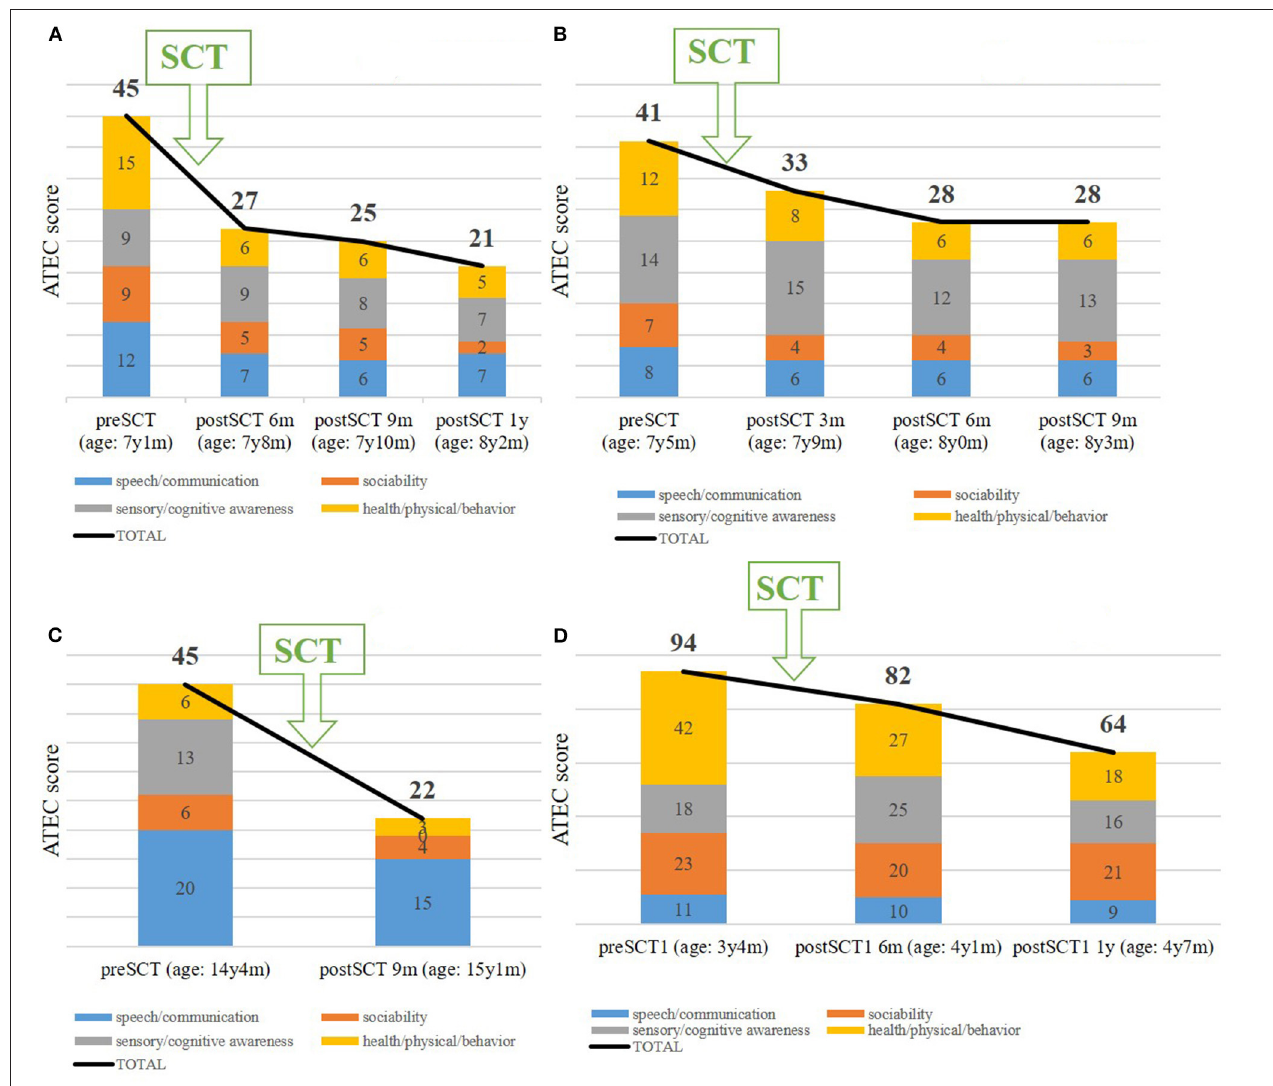
FIGURE 1 | Autism treatment evaluation checklist (ATEC) scores of (A) case #1, (B) case #2, (C) case #3, and (D) case #4 before and after stem cell Children’s stem cell transplantation